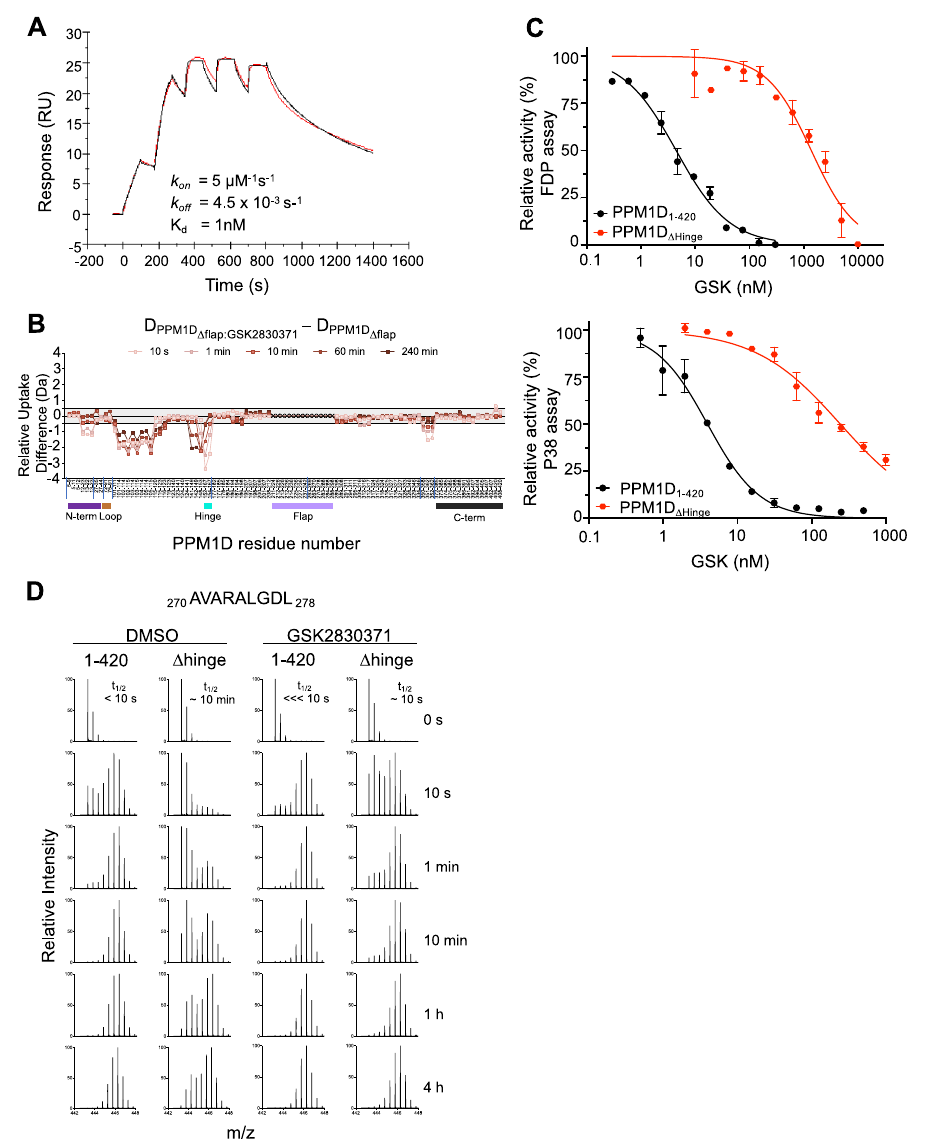
Fig. 6 The Hinge, not the fl ap, mediates GSK2830371 binding. A Surface plasmon resonance of PPM1D Δ fl ap and GSK2830371 (red represents raw data and black represents fi tted kinetic parameters). B Relative differences in deuterium uptake between PPM1D Δ fl ap in the presence of GSK2830371 compared to PPM1D Δ fl ap in the absence of GSK2830371 as assessed by HDX-MS. Vertical tick marks between peptides on the X -axis are shown to indicate regions of missing coverage. The bars below the X -axis represent the N-terminus (purple), loop (brown), hinge (cyan), fl ap (light purple), and C-terminus (black) of the protein. C Activity of GSK2830371 in the FDP (top) and p38 MAPK (bottom) enzymatic assays with PPM1D 1 – 420 (black) or PPM1D Δ hinge (red). N = 2 independent samples runs. Data are presented as mean values ± SD. D EX1 analysis showing the change in deuterium uptake for peptide 270 AVARALGDL fl ap region in PPM1D 278 located in the 1 – 420 and PPM1D Δ hinge in the absence (left) and presence (right) of GSK2830731. Source data are provided in the Source Data fi